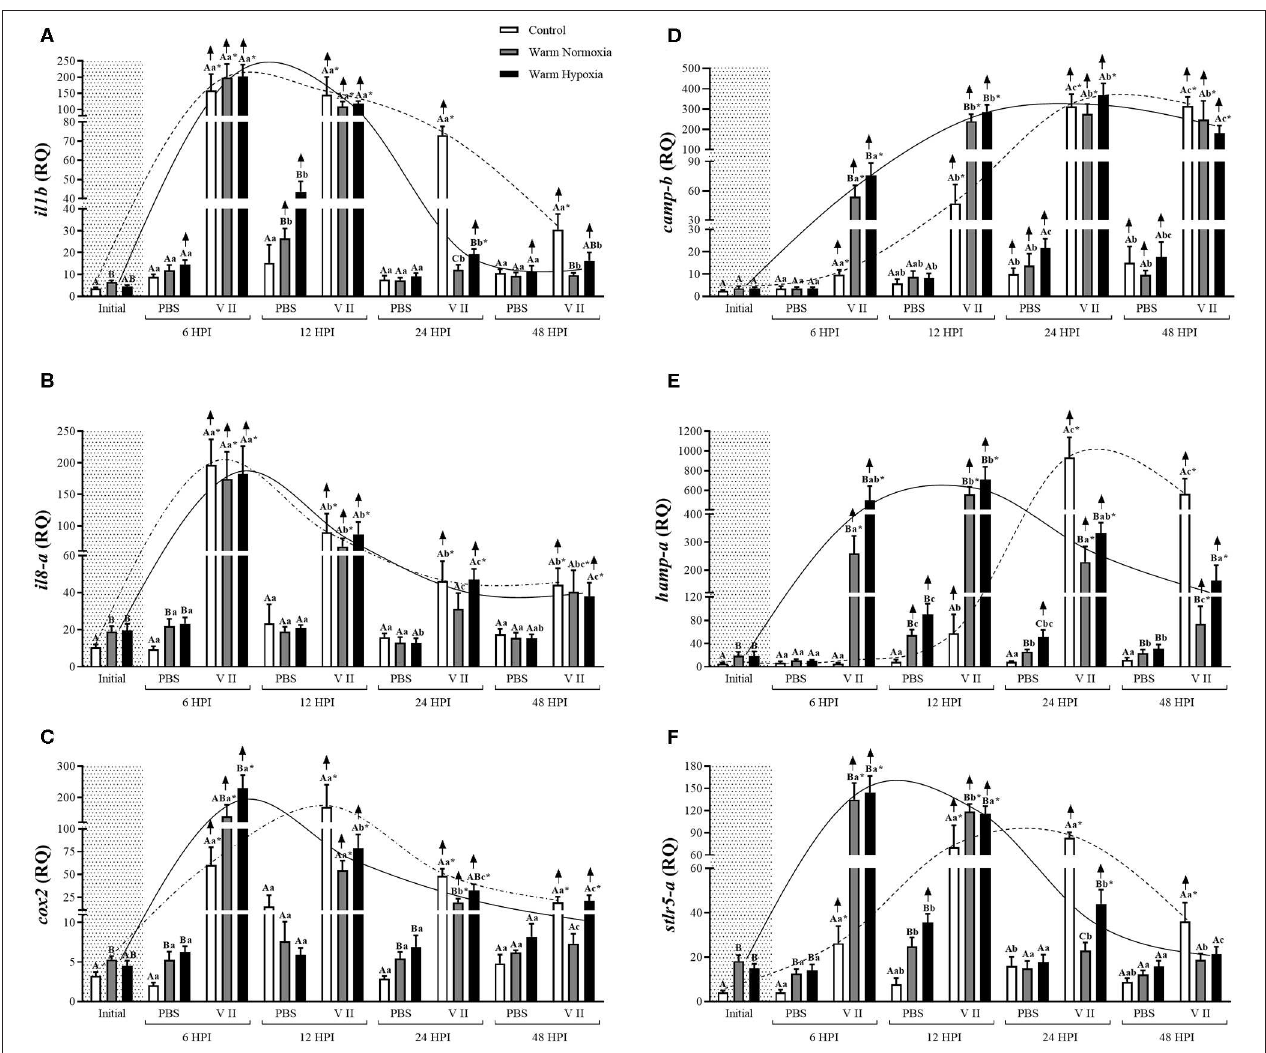
FIGURE 2 | Transcript expression levels of 6 anti-bacterial biomarkers [ il1b (A) , il8-a (B) , cox2 (C) , camp-b (D) , hamp-a (E) , and stlr5-a (F) ] in the head kidney of salmon held at 12 ◦ C (under normoxia) or 20 ◦ C (under normoxia or mild hypoxia) (i.e., treatment) 6, 12, 24, and 48h post-intraperitoneal injection with PBS or Forte V II (i.e., group). Different capital letters indicate a significant difference ( P < 0.05) among treatments within an injection group at a given time point (e.g., the three treatments six HPI after PBS injection) whereas dissimilar lower case letters indicate a significant difference over time within a treatment/group (e.g., control PBS-injected fish at 6, 12, 24, and 48 HPI). An asterisk (*) indicates a significant difference between PBS and Forte V II fish within a treatment at the same time point post-injection. The arrows indicate a significant difference compared with initial (constitutive expression) levels, within an injection group. Dotted (control) or solid lines (warm normoxia and hypoxia) illustrate the general pattern of changes in transcript expression levels for a given gene over time in Forte V II-injected fish, and are not based on any mathematical analysis. Transcript levels are presented as mean ± SE relative quantity (RQ) values (i.e., values for the transcript of interest were normalized to both etif3d and pabpc1 transcript levels and were calibrated to the individual with the lowest normalized expression level of that given transcript). N =